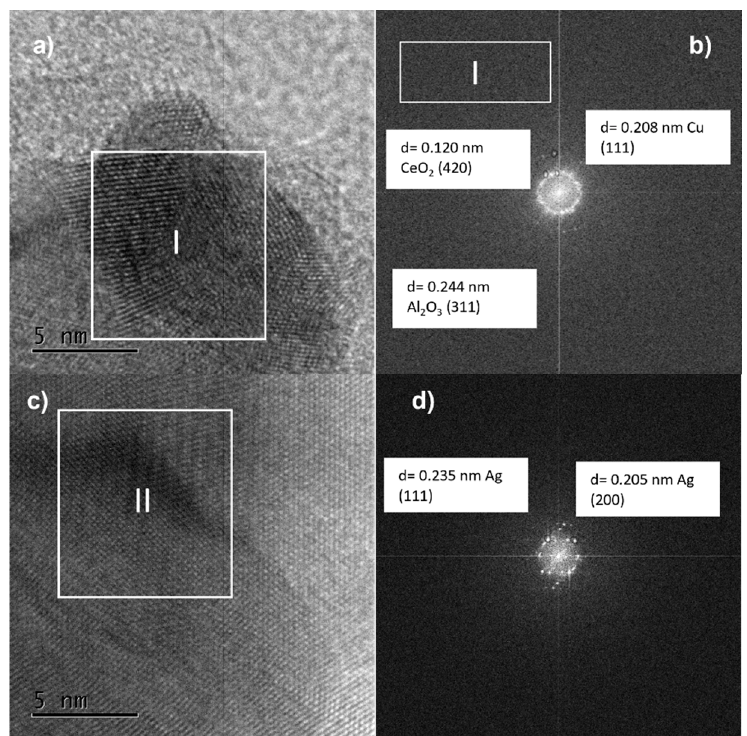
Figure 14. TEM images at 5 nm ( a , b ) and lattice spacing of arbitrarily selected nanoparticles ( c , d ) of fresh AgCuAlCe bimetallic catalyst.